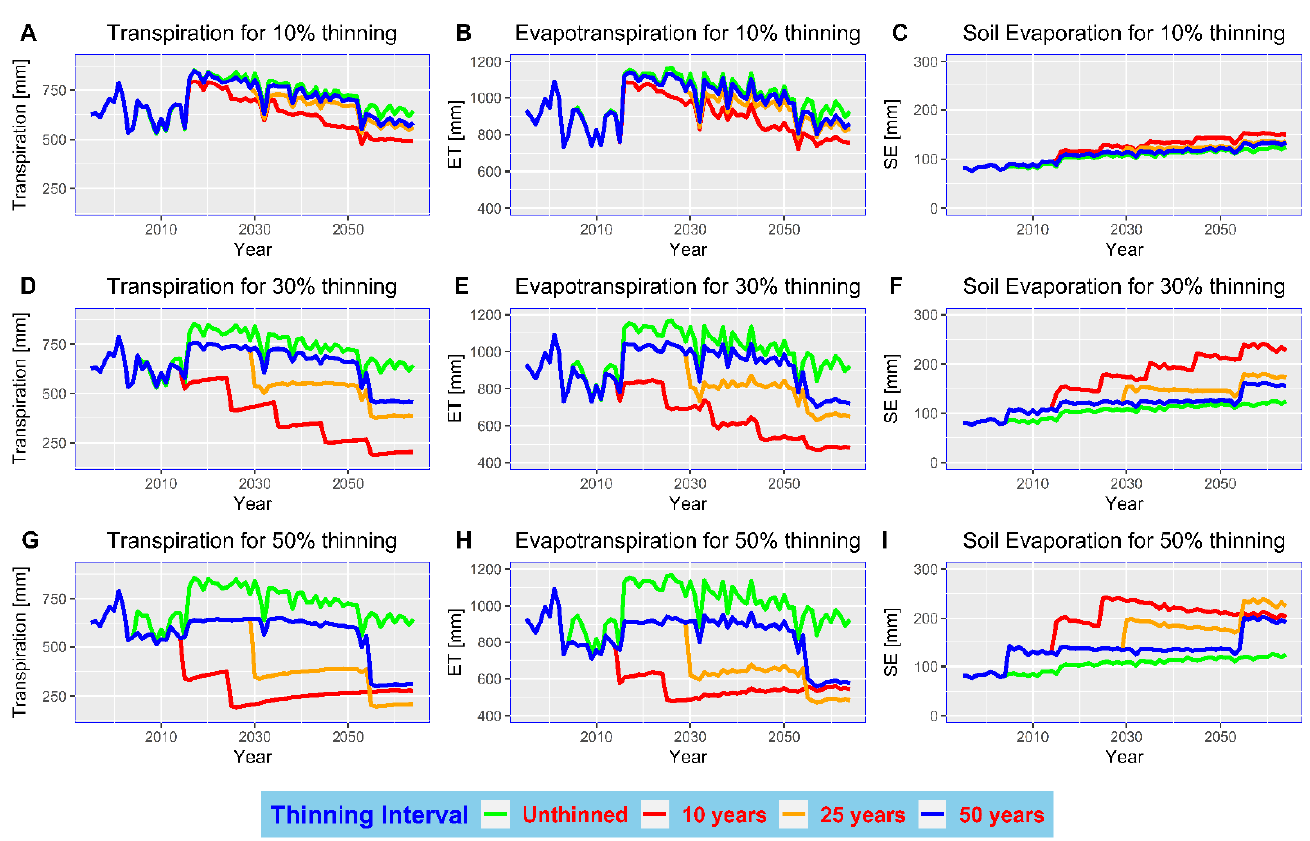
Figure 2. Transpiration ( A , D , G ), ET ( B , E , H ) and soil evaporation ( C , F , I ) for 10%, 30%, and 50% thinning respectively in different thinning intervals.